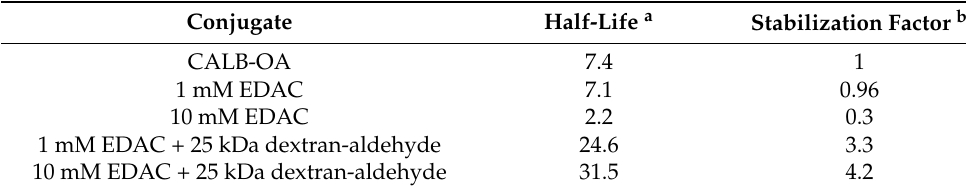
Table 4. Half-life and stabilization factor of optimal CALB